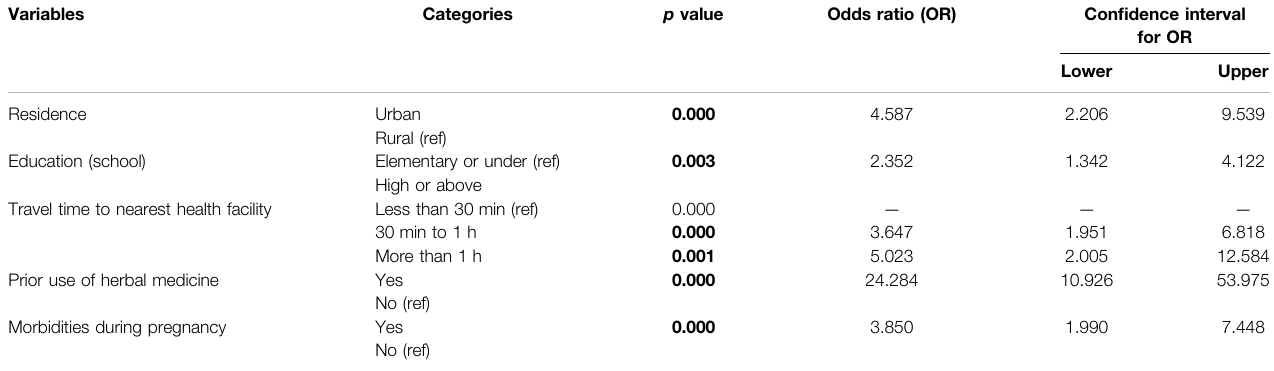
TABLE 3 | Logistic regression model showing factors predicting HM use during pregnancy.